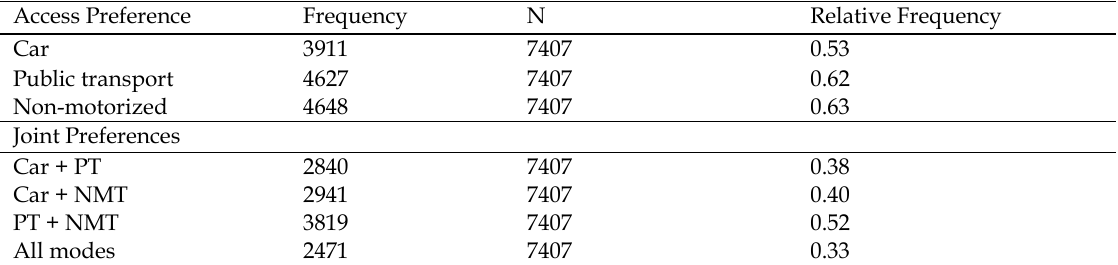
Modal access preferences when choosing current residential